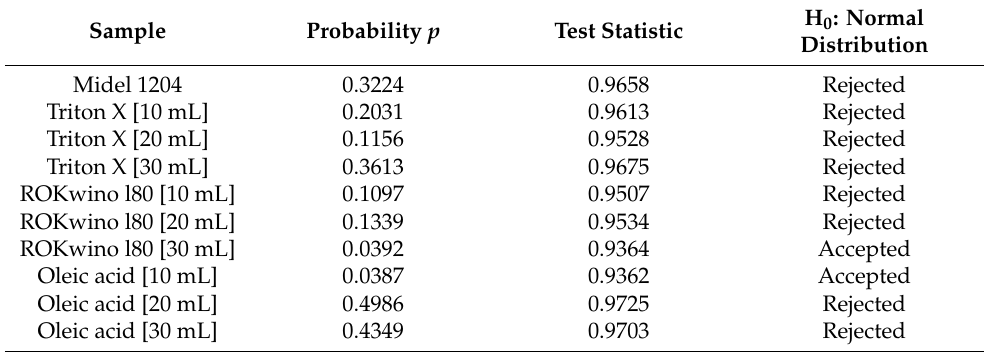
Table 4. Tests of normality distributions for all samples.